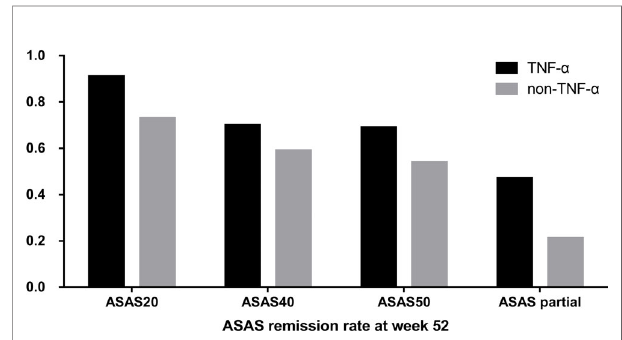
FIGURE 1 | Distribution of Assessment of SpondyloArthritis international Society (ASAS) remission rates between the group that received tumor necrosis factor (TNF)- a inhibitors and the control group at week